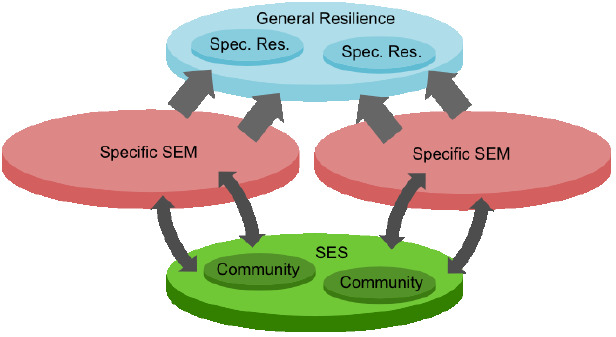
Fig. 2 . Alternative casual mechanism identified. Social- ecological memory (SEM) exists as a diversity of specific SEMs, leading to a range of specified resilience. The two specific SEMs are connected to two different pathways of development of two groups within the social-ecological system